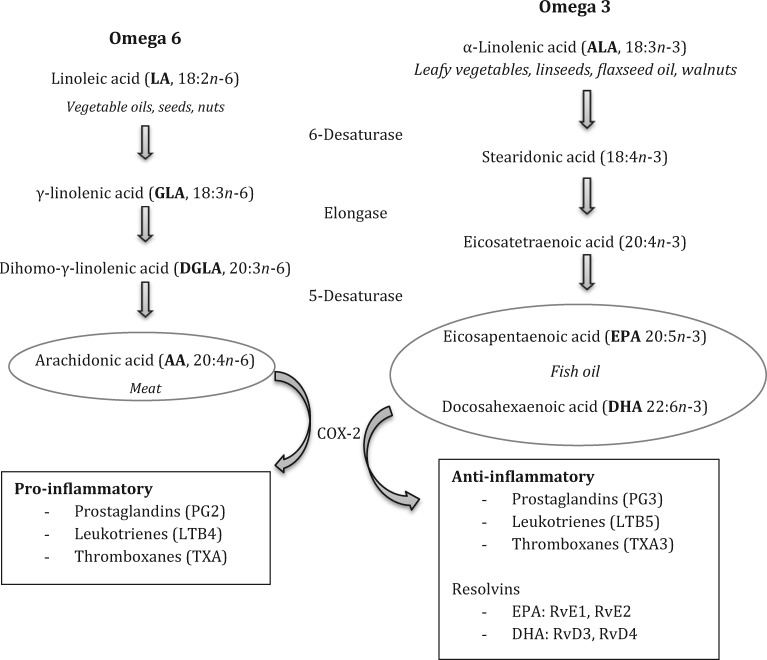
Essential fatty acids: elongation and chain saturation, dietary sources and inflammatory effectsAdapted from Rayman and Callaghan [61, 62].